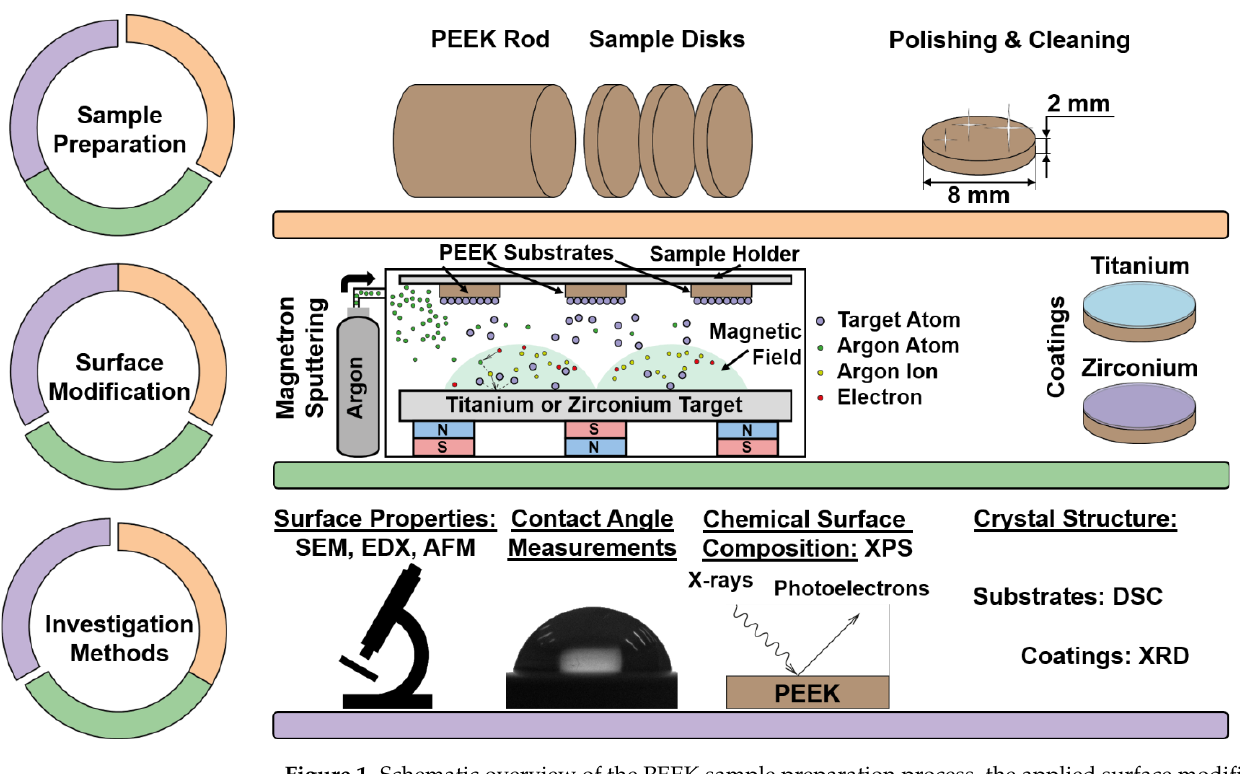
Figure 1. Schematic overview of the PEEK sample preparation process, the applied surface modification method, and the investigation methods used in this study.